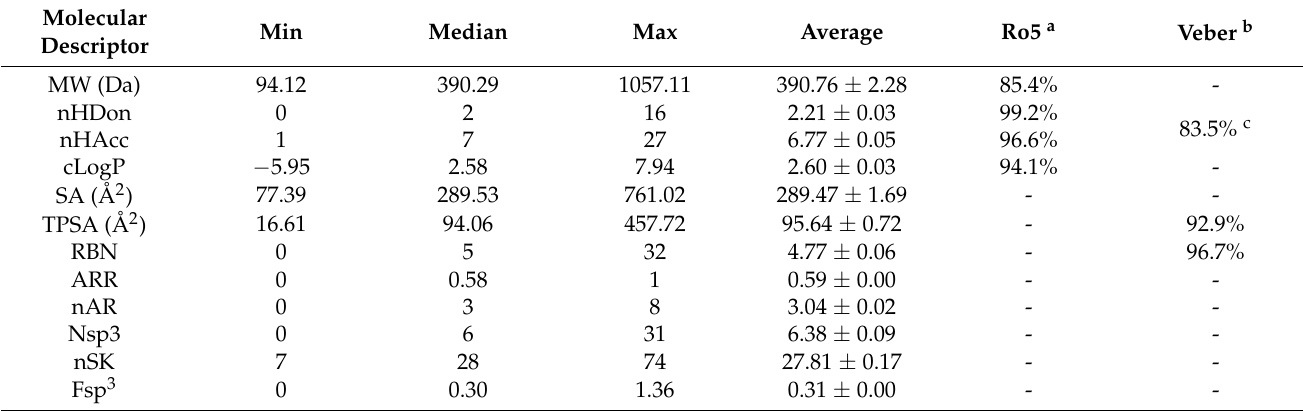
Table 2. Values of molecular